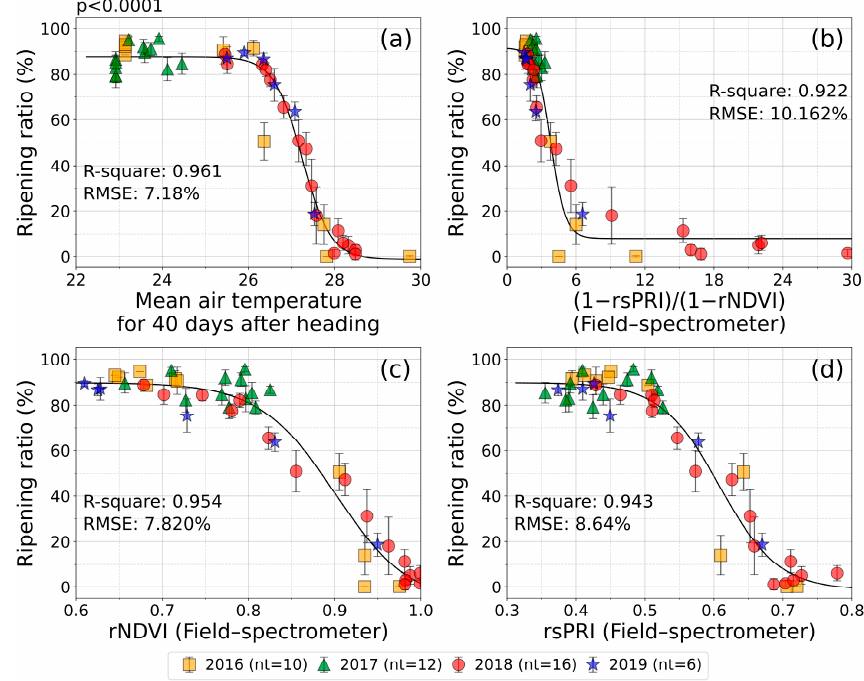
Figure 13. Relationship between ripening ratio of paddy rice and ( a ) mean air temperature for 40 days after heading, ( b ) (1 − rsPRI)/(1 − rNDVI), ( c ) rNDVI, and ( d ) rsPRI. Each relationship equation was presented in Table 2. NDVI and PRI were calculated using spectral reflectance measured from field- spectrometers (canopy scale). rNDVI and rsPRI indicate the relative change in vegetation index after the heading stage of paddy